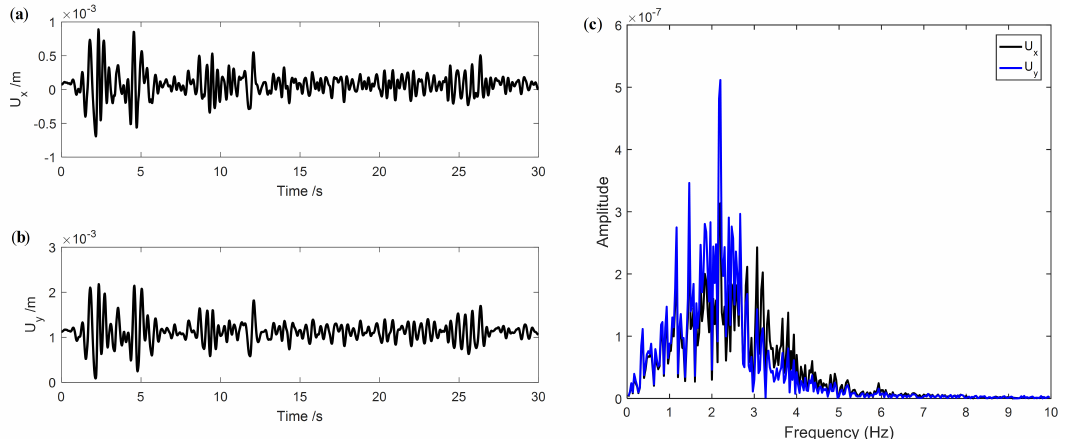
Figure 7. Displacement responses of the CCGB: ( a , b ) U x and U y in time domain; ( c ) U x and U y in frequency